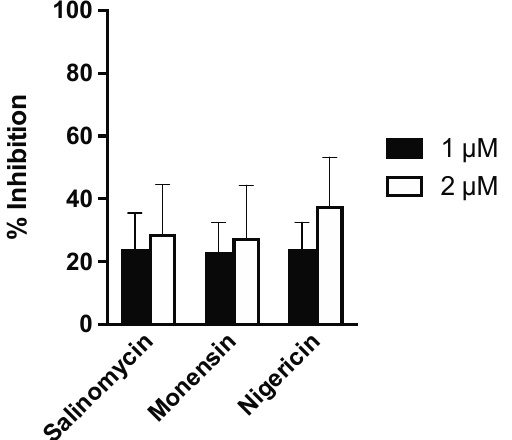
Figure 4. Antiparasitic activity of ionophores against amastigotes of L. infantum in canine macrophages. Infected cells were treated with two ionophore concentrations (1 and 2 µ M) for 72 h and subsequently stained with Giemsa to calculate the proportion of infected cells. The % of inhibition in drug-treated samples was then quantified by considering the infection in untreated controls as